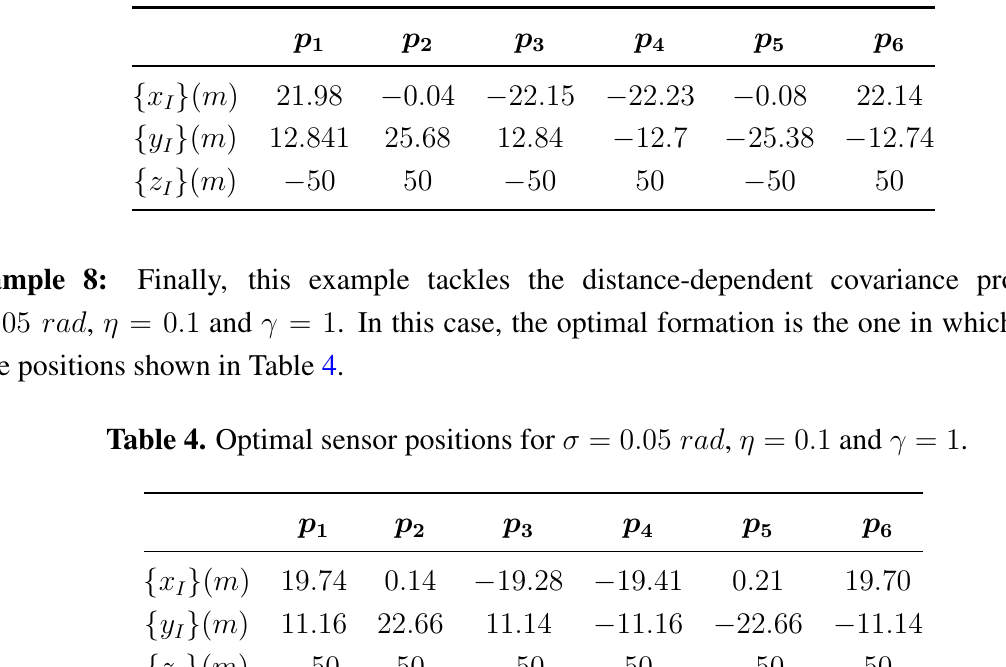
Table 3. Optimal sensor positions for constant covariance.